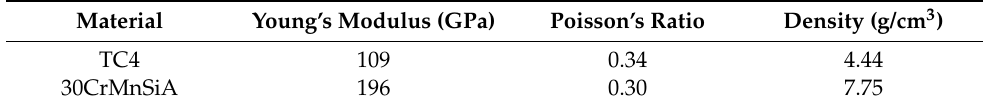
Table 1. Properties of mental materials used in the actuator.